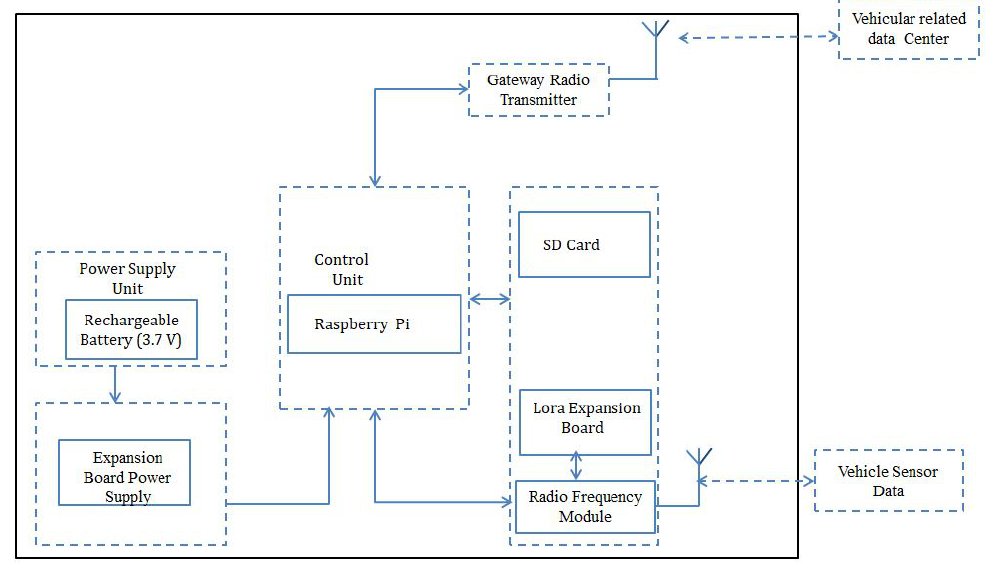
Figure 17. Block Diagram of the gateway